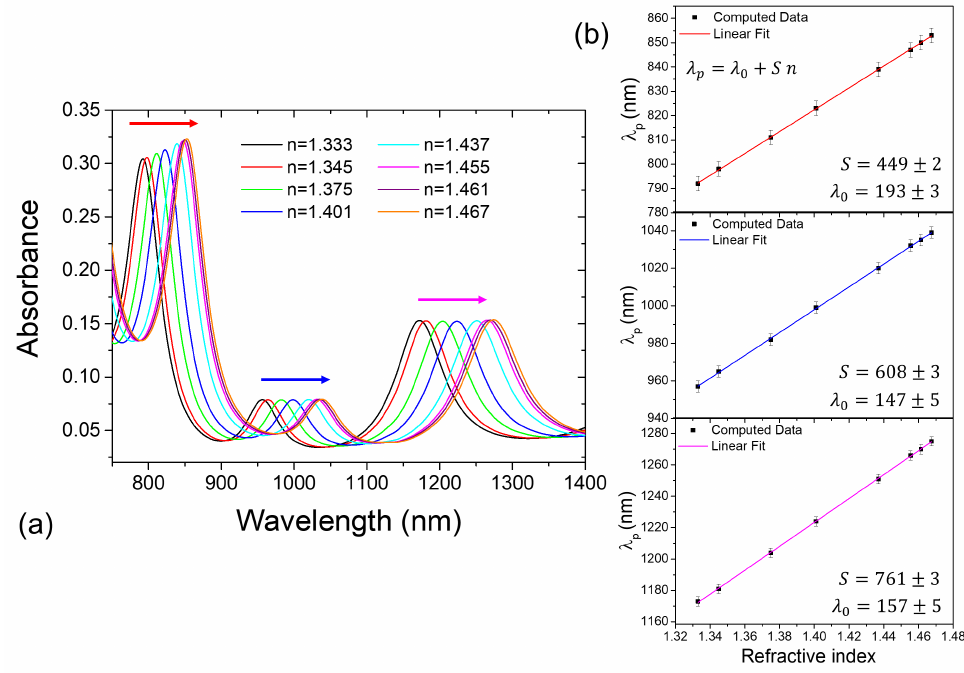
Figure 3. ( a ) Spectral characterization of the plasmonic metasurface: absorbance spectra calculated for different concentrations of 1,2,3-Propantriol for a = 250 nm; ( b ) linear fit of the peak wavelength plotted versus the refractive index of the medium for the three resonant modes. The fitting equation is λ p = λ 0 + Sn ; the correlation coefficient is R = 0.99 for the three fits. In Figure 3a, the three arrows indicate the gradual red shift of the resonant peaks registered by constantly increasing the refractive index from 1.333 (water) to 1.467 (82.4% glycerol), while in Figure 3b, the corresponding peak positions as a function of the refractive index, are reported. The three plots (see Figure 3b, top, middle, and bottom panels) highlight